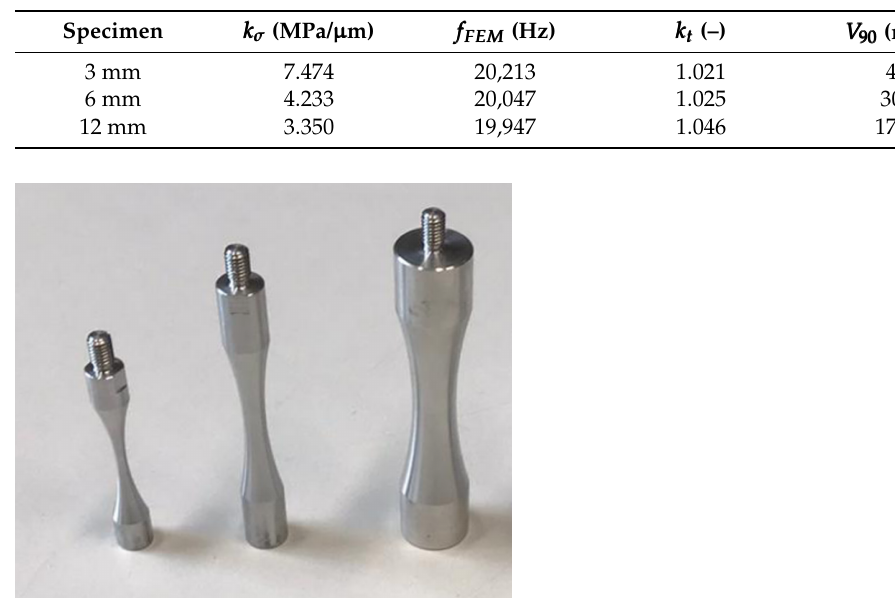
Table 3. Dynamic mechanical properties and risk-volume of the investigated three different specimens.